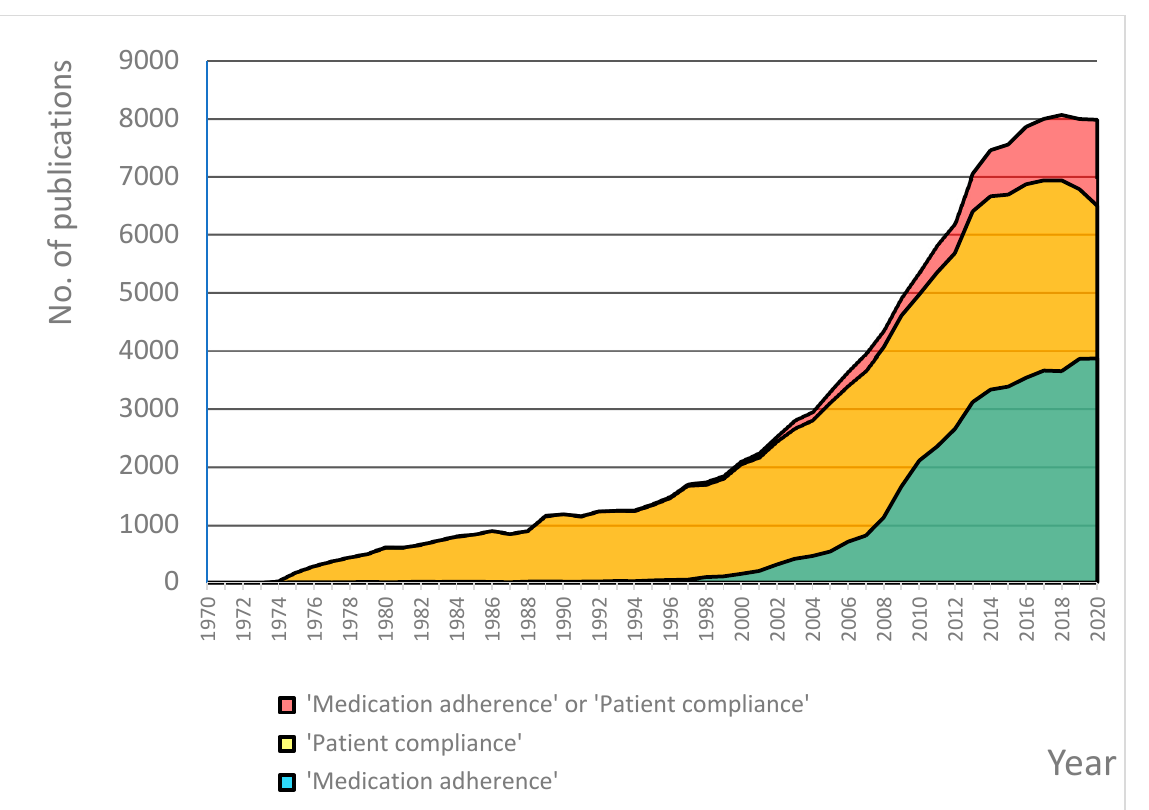
Figure 1. The yearly numbers of scientific publications on medication adherence, by keyword used, retrieved by the PubMed online database for the period 1970–2020.